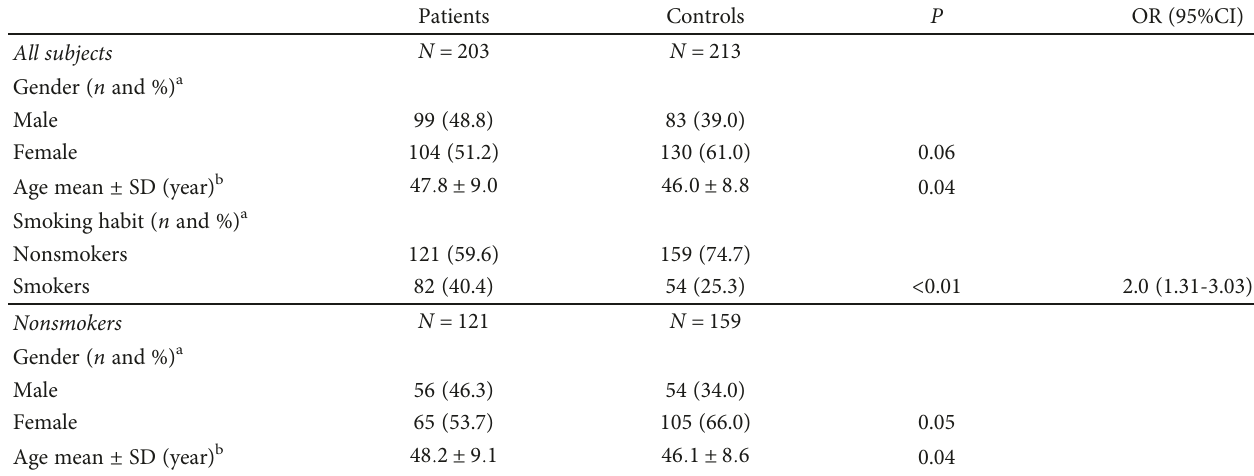
Table 1: Characteristics of patients with periodontitis and